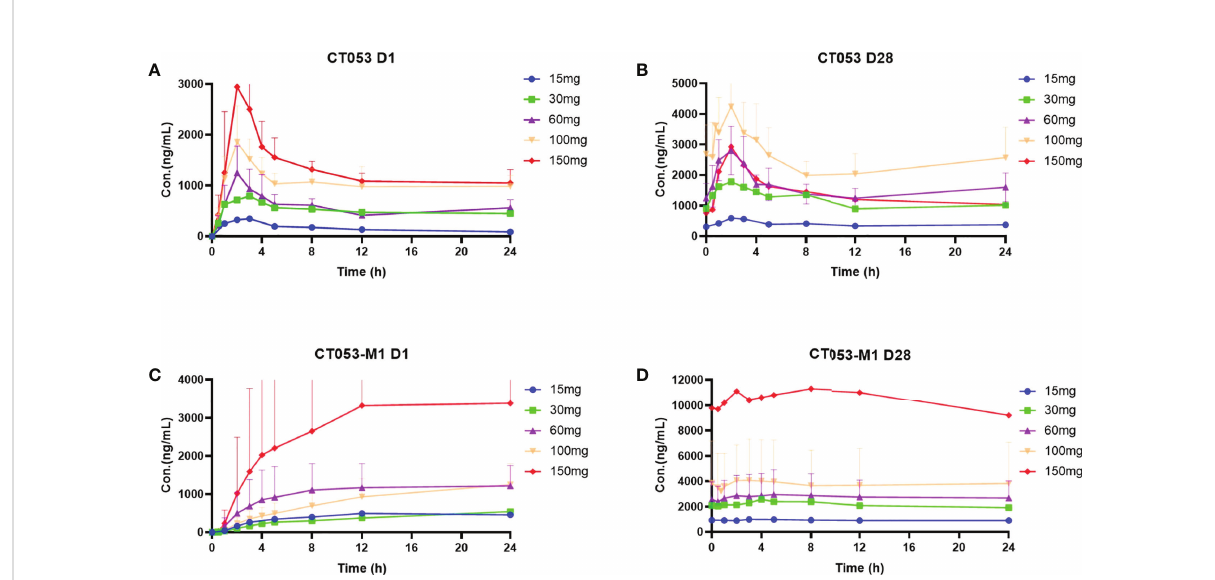
FIGURE 4 Concentration-time pro fi les (mean ± SD) of plasma CT053PTSA and CT053-M1 levels by cohort after a single dose (Day 1) after multiple oral doses (Day 28). (A) CT053PTSA levels after a single dose. (B) CT053PTSA levels after multiple oral doses. (C) CT053-M1 levels after a single dose. (D) CT053-M1 levels after multiple oral